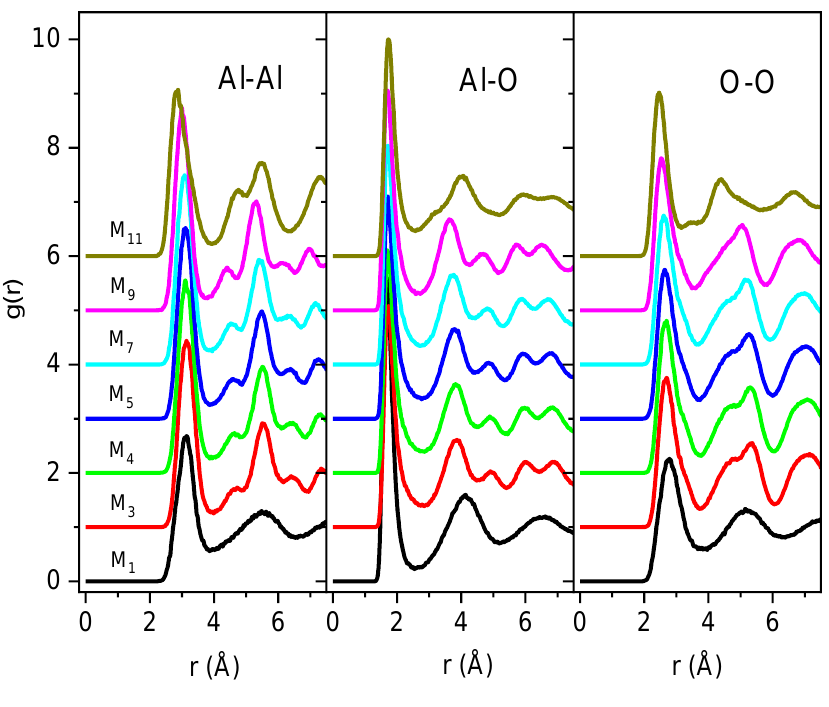
Figure 1. The radial distribution function of liquid Al 2 O 3 at different pressures